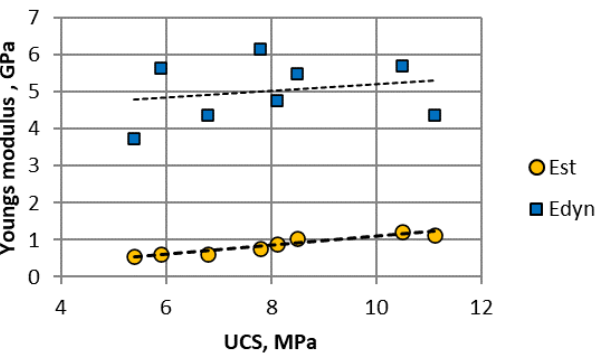
Figure 12. Linear regression analysis results of E st , E dyn = f (UCS) for coals sampled from the same locations in mine workings.